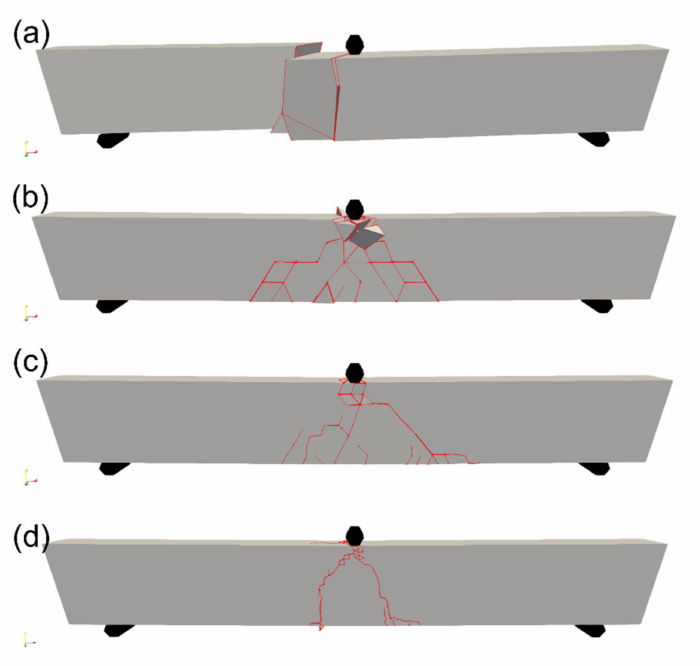
Figure 9. The resultant crack pattern of RC beam as a result of numerical simulations with var- ious finite concrete element sizes: ( a ) h ave = 100 mm, ( b ) h ave = 50 mm, ( c ) h ave = 25 mm and ( d ) h ave = 12.5